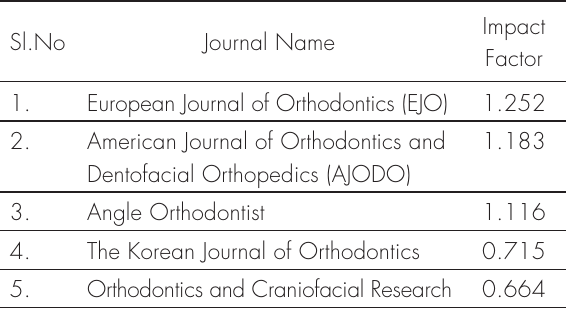
Table I. Orthodontic Journals selected along with their impact factor based on Metrics based on Scopus ® data as of April